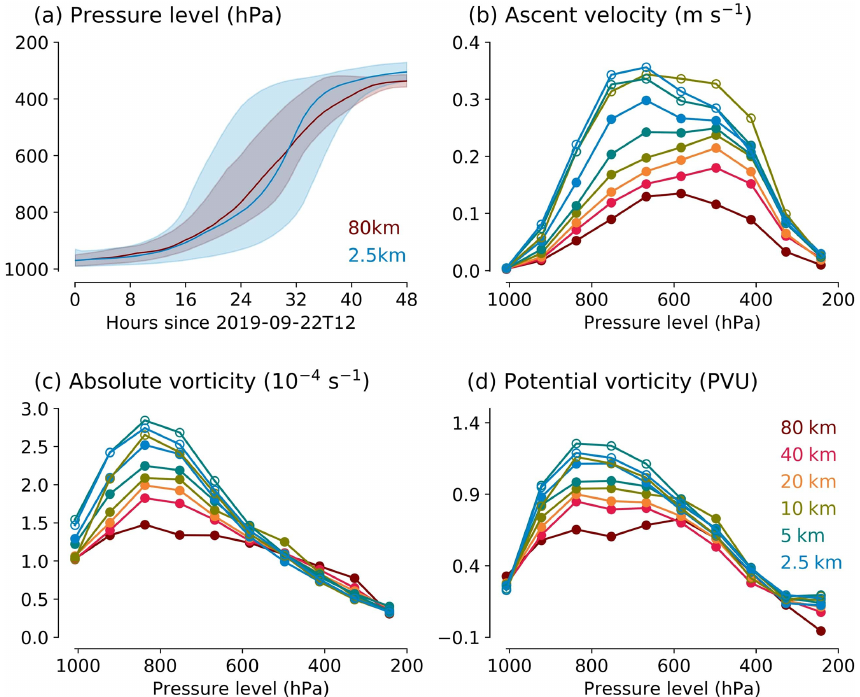
Figure 7. (a) Vertical location of WCB air parcels (measured by their pressure level) as a function of time for simulations with 80 and 2.5km grid spacings, parameterized convection and one-moment cloud microphysics. The shading illustrates the spread between trajectories and is given by the 25th and 75th percentiles. (b) Ascent velocity, (c) absolute vorticity and (d) potential vorticity as a function of grid spacing and pressure level averaged over all trajectories. Lines with filled and empty markers represent simulations with parameterized and explicit convection, respectively. All simulations shown here use one-moment cloud